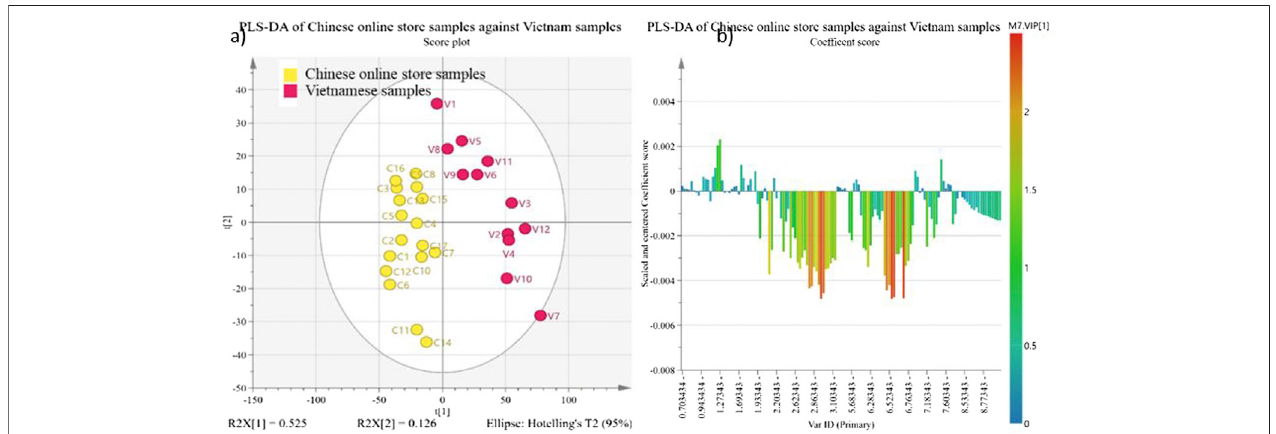
FIGURE4| PLS-DAofChineseonlinestoresamplesagainstVietnamesesamples.ThePLS-DAcorrespondstothebinnedregionsof 1 H-NMRspectraofChinese online store samples (C1 – C17) and Vietnamese samples (V1 – V12) as X variables and the value chains of samples as the Y variable. All X variables are scaled by Pareto scaling.Theyellowcolourin (A) PLS-DAscatterscoreplotrepresentstheChineseonlinestoresamples,andthepinkrepresentsVietnamesesamples.Thecoloursofthe samples in fi gure (B) loading plot are referring the VIP value of the X variable contribute to the principal component 1.